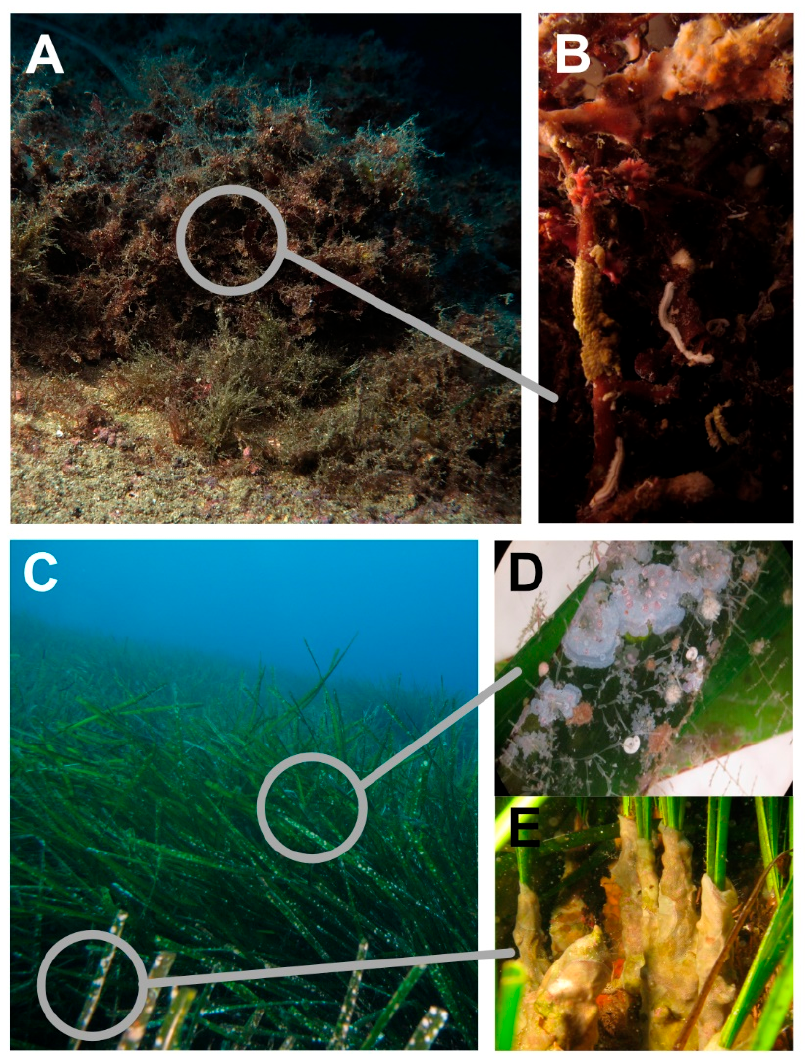
Figure 1. Top: P. crispa mat in full view ( A ) and close up including sessile polychaetes and other epifauna ( B ). Bottom: P. oceanica mat as seen from the water column ( C ) and close-ups of the leaves ( D ) and shoots ( E ), showing different sessile epifauna. Pictures: F. I. Rossbach. tat created by mat-forming, fleshy red alga Phyllophora crispa (Hudson) P.S.Dixon,